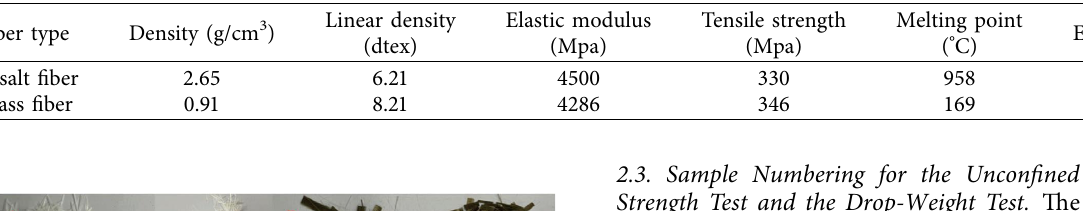
Table 2: Fiber parameters.